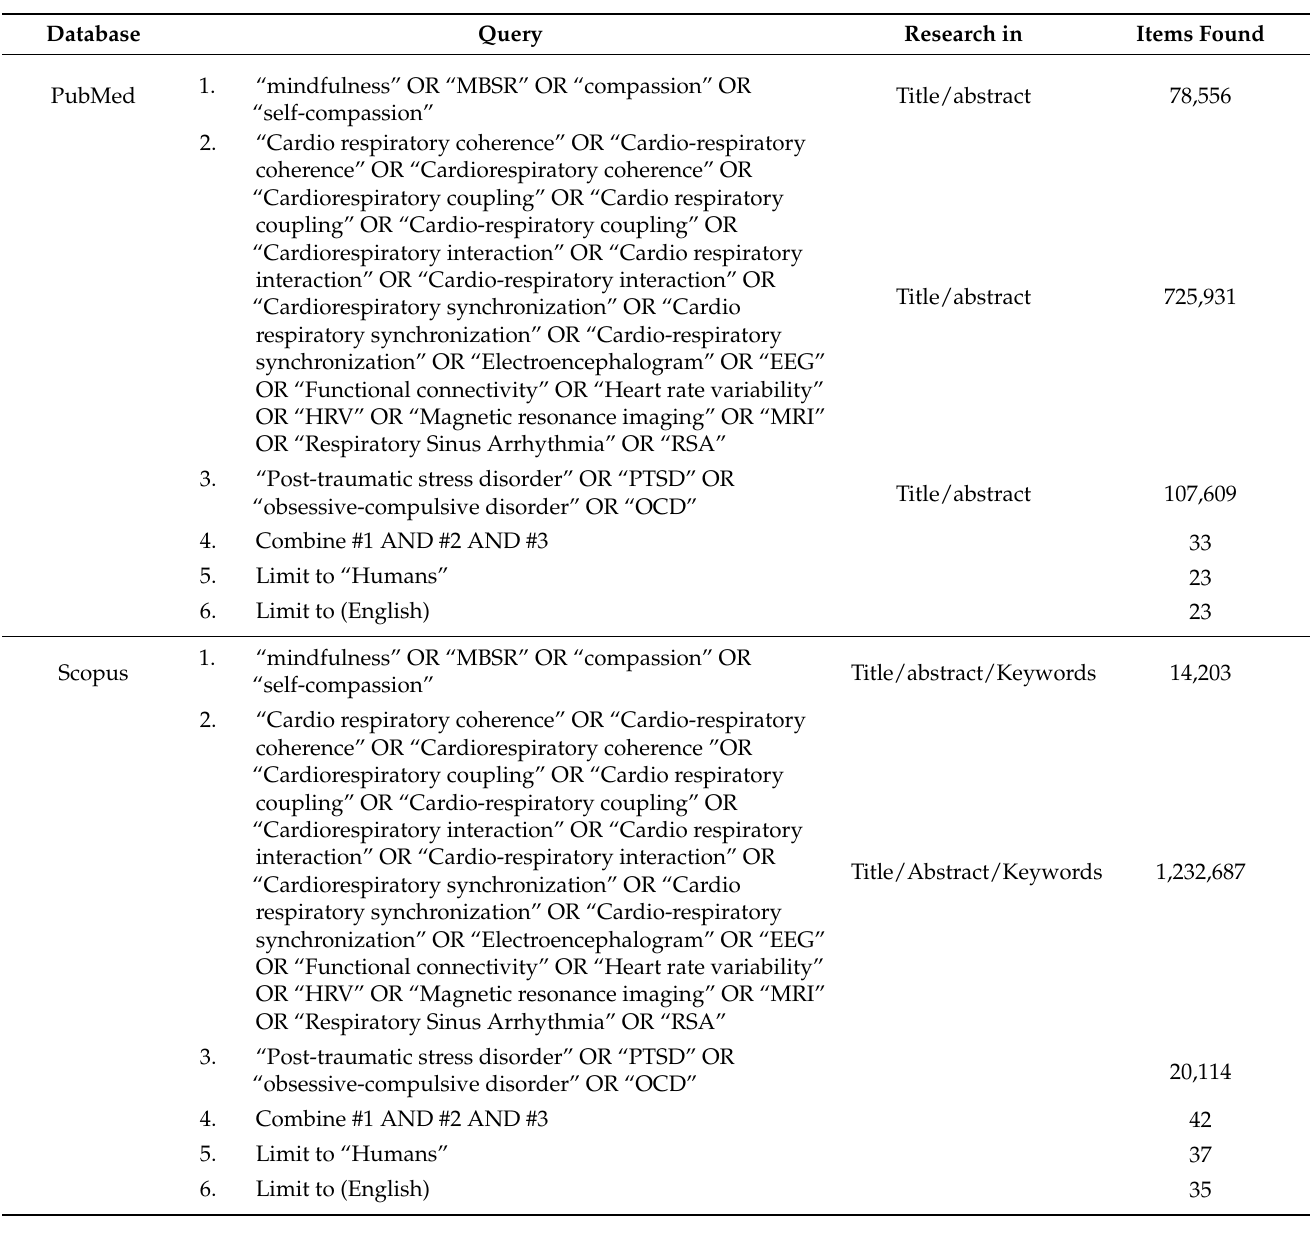
Table 2. Search strategy of the